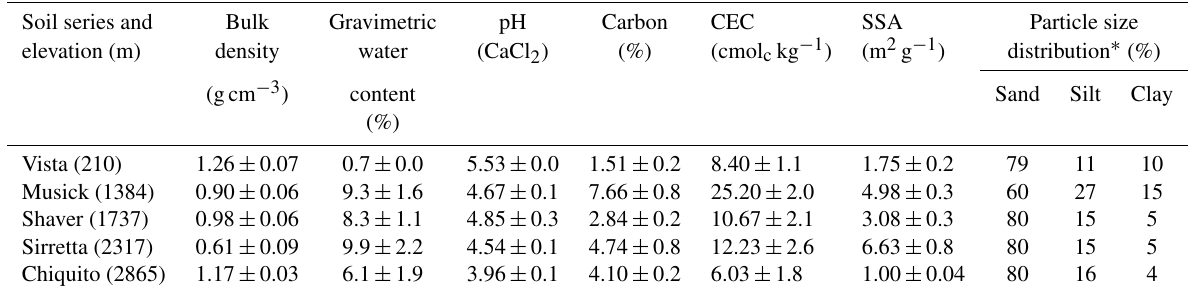
Table 2. Bulk density, water content, pH, C concentration, cation exchange capacity (CEC), specific surface area (SSA) and particle size distribution for the five soils (mean ± standard error, n = 3). Soil series and Bulk Gravimetric pH Carbon SSA